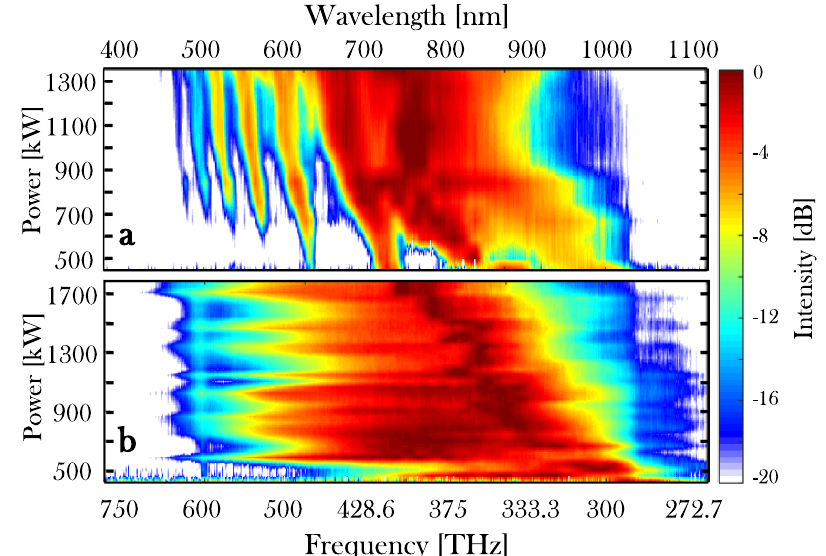
Fig. 5 Experimental results indicating the blue-shifting of dispersive waves resulting from the nonlinear phase term. a Experimentally measured blue- drift of dispersive waves (DWs) in a parabolic multimode fi ber (MMF) as a result of increasing the input power levels. The blue drifting of DWs arises from the nonlinear phase term (last term in Eq. 7). b Experimentally measured blue-drifting of DWs for a step-index MMF when the input power increases. In both cases, a similar trend is observed. We note that the maximum power level used in these experiments 1.7 MW is well below, the threshold power required at 1.55 µ m for catastrophic self-focusing (10 MW) in silica fi